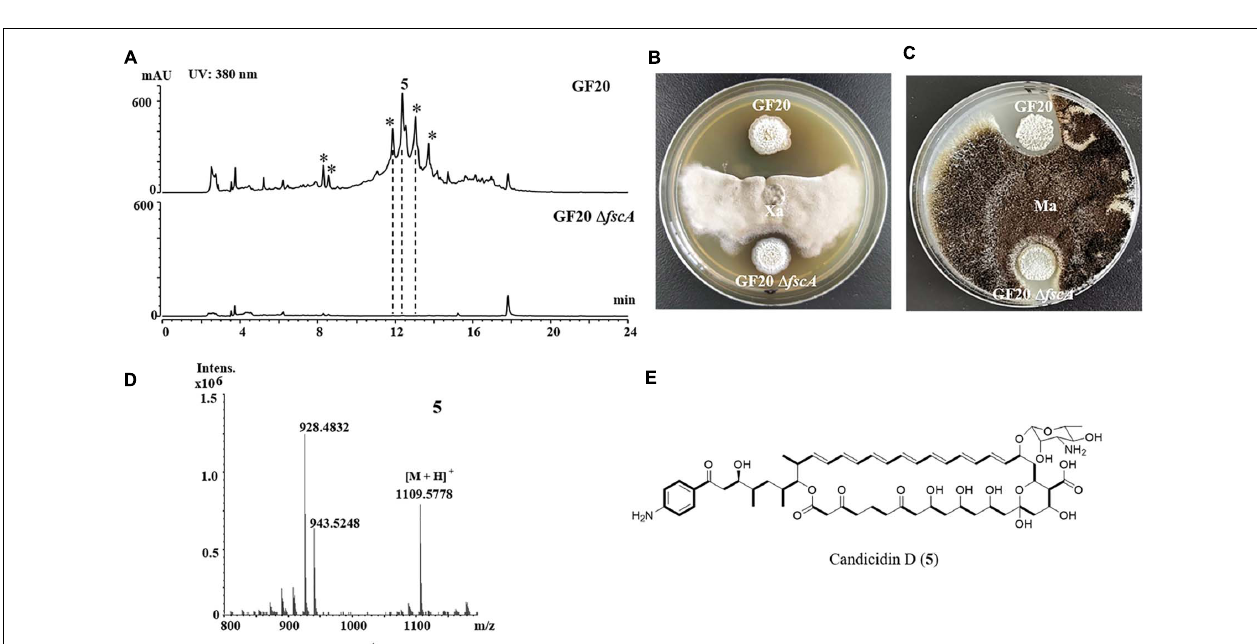
FIGURE 7 | The deletion mutant of candicidins in Streptomyces sp. GF20 had weaker antifungal activities against Xylaria sp. and M. anisopliae . (A) HPLC profiles of the metabolites of wide type Streptomyces sp. GF20 and mutant GF20 (cid:49) fscA . The asterisk symbols ( ∗ ) denote homologs of candicidin. (B,C) , paired challenge assays of GF20 and the deletion mutant (GF20 (cid:49) fscA ) against Xylaria sp. (Xa, B ) and M. anisopliae (Ma, C ). (D) HRMS spectrum of compound 5 from GF20. (E) The predicted structure of candicidin D (5).